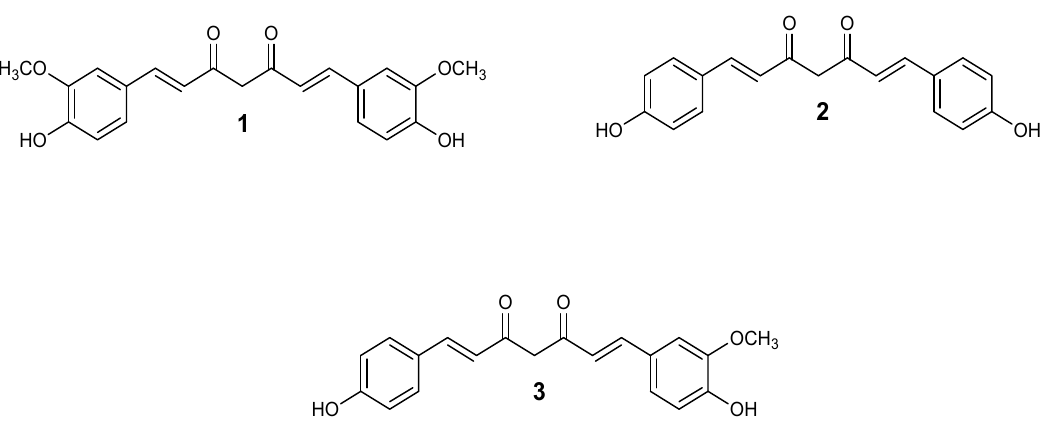
Figure 1. Chemical structure of curcumin, bisdemethoxycurcumin, and demethoxycurcumin.